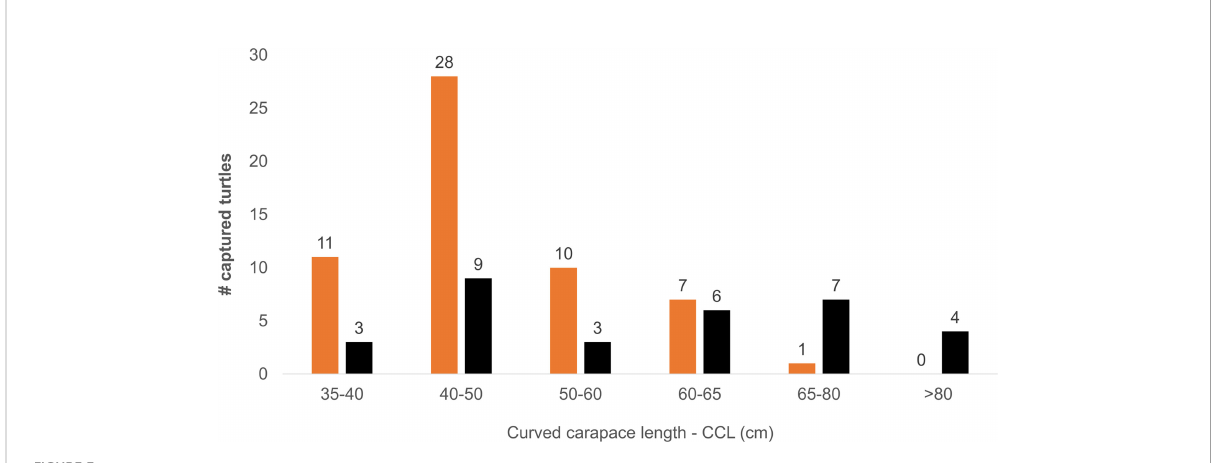
FIGURE 3 Size distribution of green turtles captured at foraging areas around Unhocomo and Unhocomozinho islands, Guinea-Bissau. Color indicates habitat of capture, black – rocky-bottom, orange – sandy-bottom.